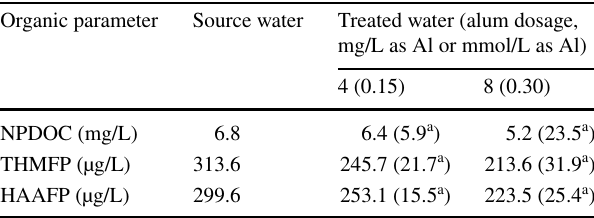
Table 4 The NPDOC and THMFP of the source water and